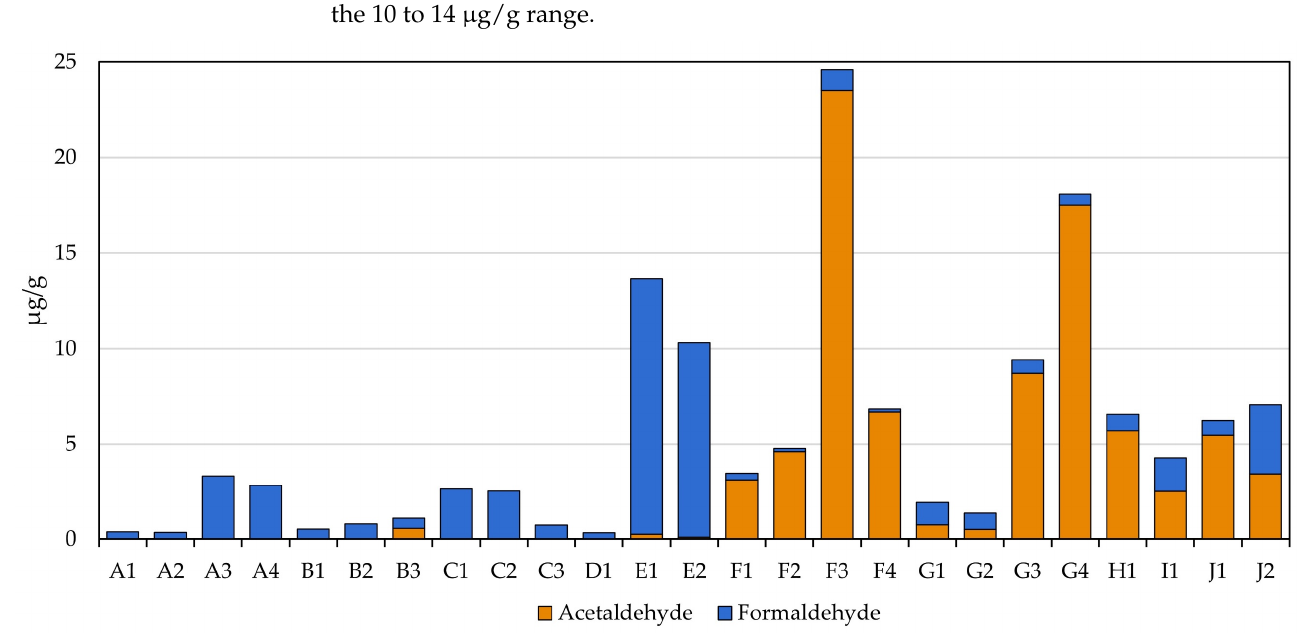
Figure 2. Observed levels of formaldehyde and acetaldehyde in the MONPs and four STPs.